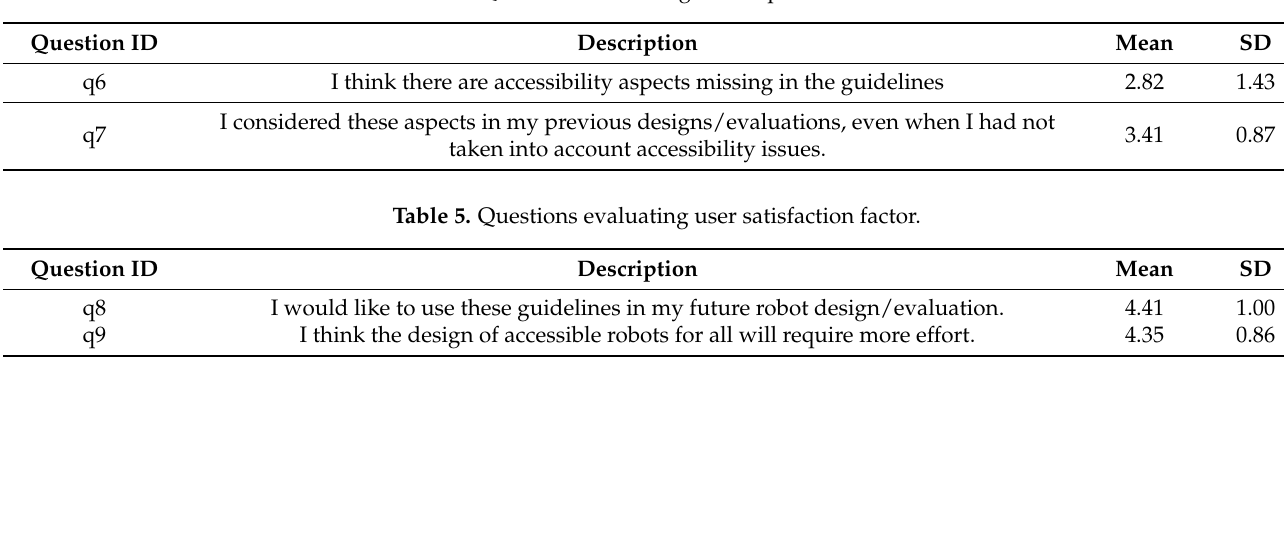
Table 4. Questions evaluating user experience factor.